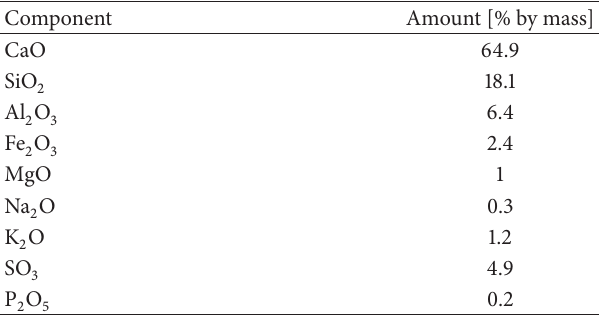
Table 2: Chemical composition of cement CEM I 52.5 R.